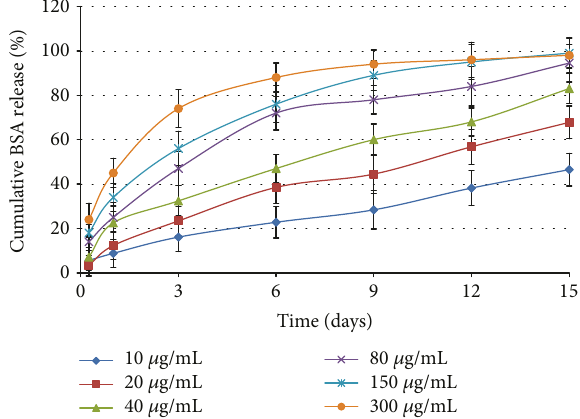
Figure 3: E ff ect of di ff erent concentrations of loaded BSA to the in vitro release pro fi le of BSA-Alg/Col/HA.